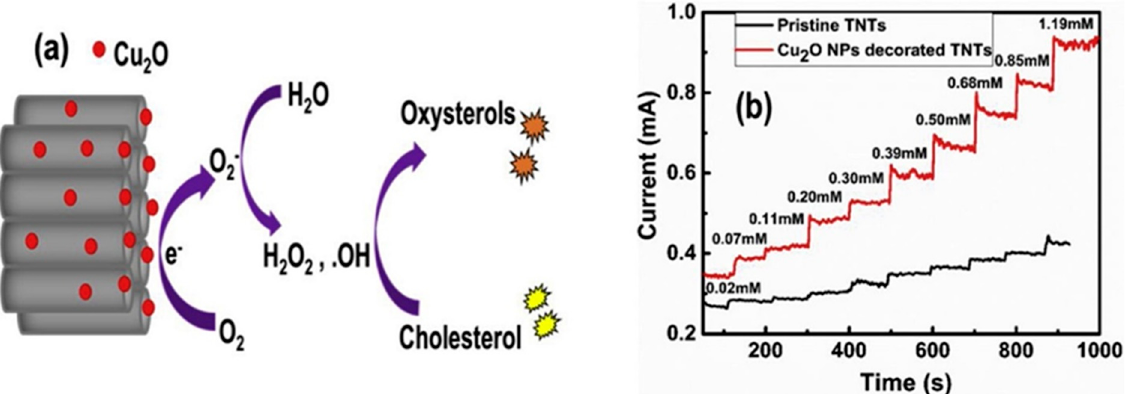
Figure 2. ( a ) Schematic representation of the oxidation of cholesterol at the surface of Cu 2 O NPs-TNTs electrode; ( b ) Amperometry of TNTs and Cu 2 O-decorated TNTs. Reprinted with permission from Ref. [35].